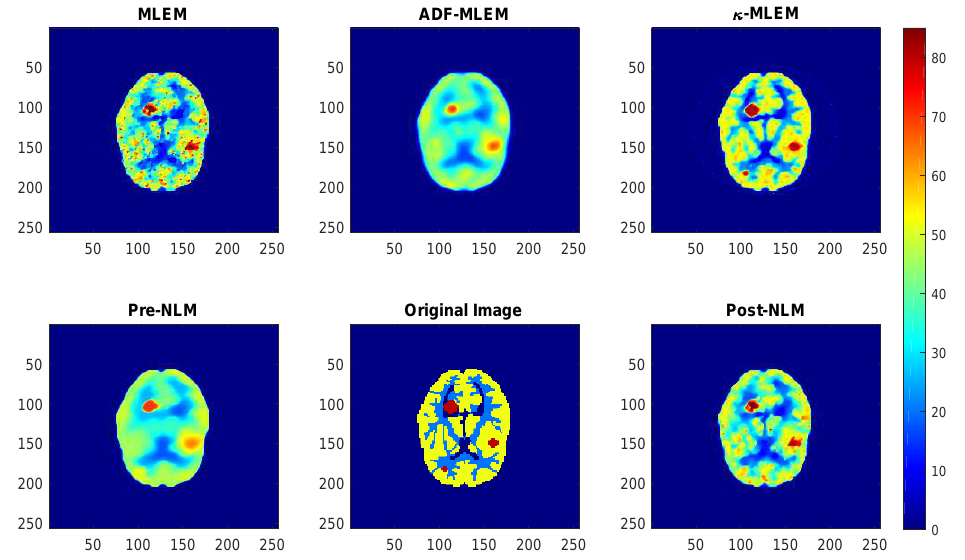
Figure 4. Reconstructed images of the Hoffman brain phantom by different algorithms with 150 iterations. MLEM: maximum-likelihood expectation-maximization; κ -MLEM: the experimental kernel-based MLEM; ADF-MLEM: the penalized likelihood reconstruction regularized by anisotropic diffusion filter; Pre-NLM: MLEM precondition reconstruction algorithm that was regularized by non-local means; Post-NLM: post-reconstruction de-noising methods applied